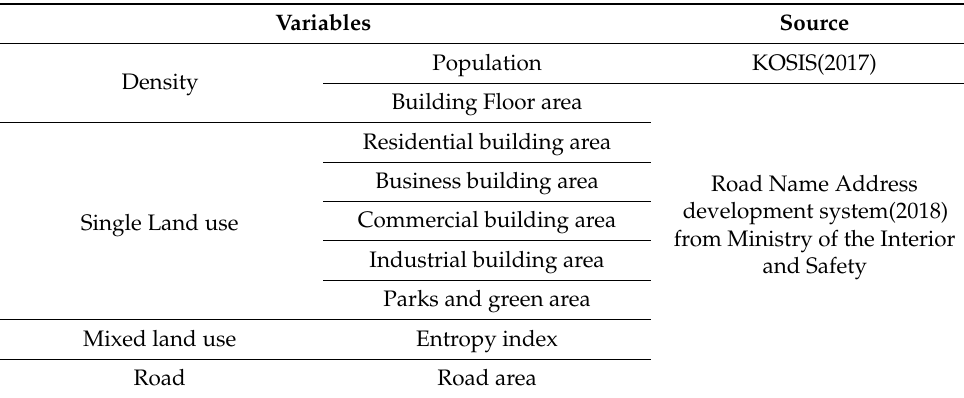
Table 1. Variables and Data Sources for